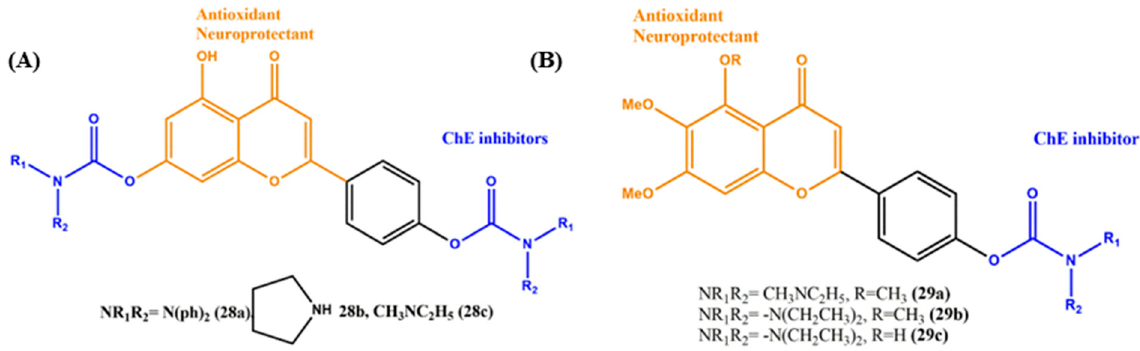
Figure 11. Chemical structures of rivastigmine-derived MTDLs for